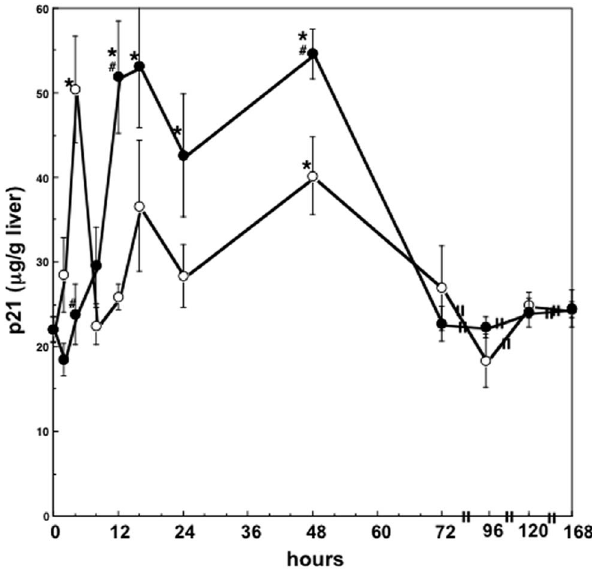
Figure 8. The effect of p21 antisense on DNA synthesis of hepatocytes in the presence of HGF. Rat hepatocytes were cultured at high density in WE containing 10% FCS, 10 ng/mL HGF, 1 mmol/L BrdU, along with various concentrations of either p21 antisense or nonsense oligonucleotide for 24 hours. An open bar denotes hepatocytes cultured in the absence of HGF. Closed bars denote hepatocytes cultured with p21 antisense oligonucleotide in the presence of 10 ng/mL HGF. A dotted bar denotes hepatocytes cultured with nonsense oligonucleotide in the presence of 10 ng/mL HGF. Data are mean 6 SEM of eight dishes. *p , 0.05 compared with the values treated only with HGF, and # p , 0.01 compared with the values treated with HGF and nonsense oligonucleotide.